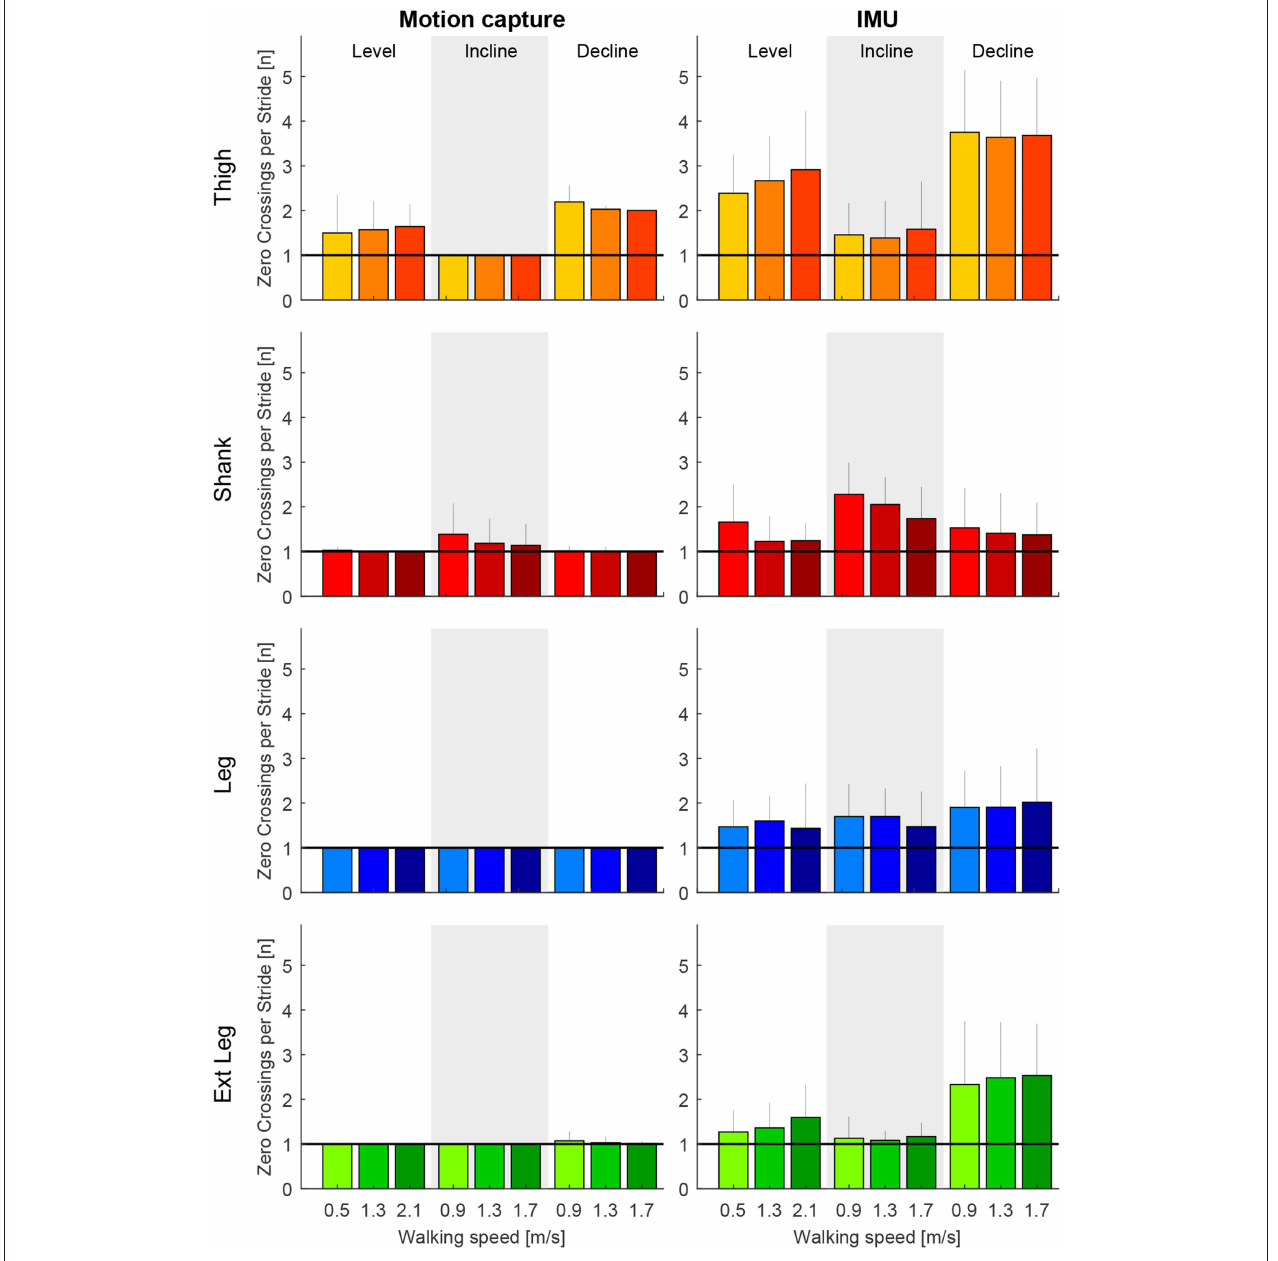
FIGURE 6 | Number of zero crossings of the angular velocity per gait cycle for the thigh (orange), shank (red), leg (blue), and extended leg segment (green) in level walking, inclined walking (10 ◦ ) and declined walking (10 ◦ ). The angular velocity was determined by motion capture (left) and by inertial measurement units (right) . Darker colors represent greater speeds (0.9, 1.3, and 1.7m/s for slopes, 0.5, 1.3, and 2.1m/s for level walking). Error bars represent one standard deviation.